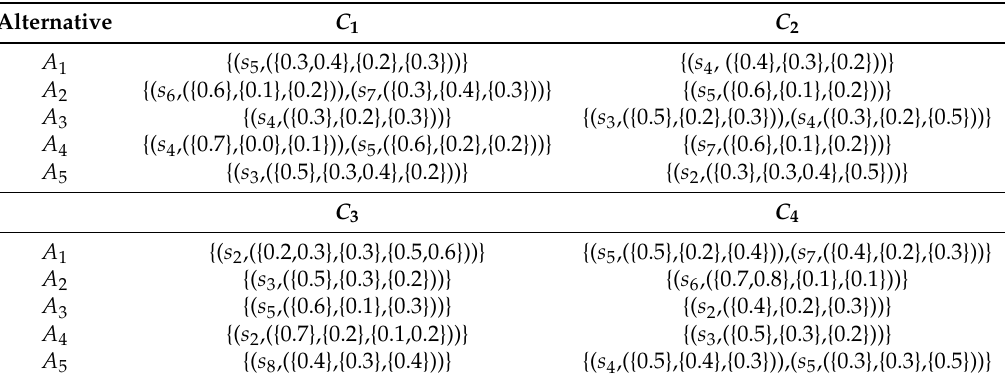
Table 1. Decision matrix D 1 .